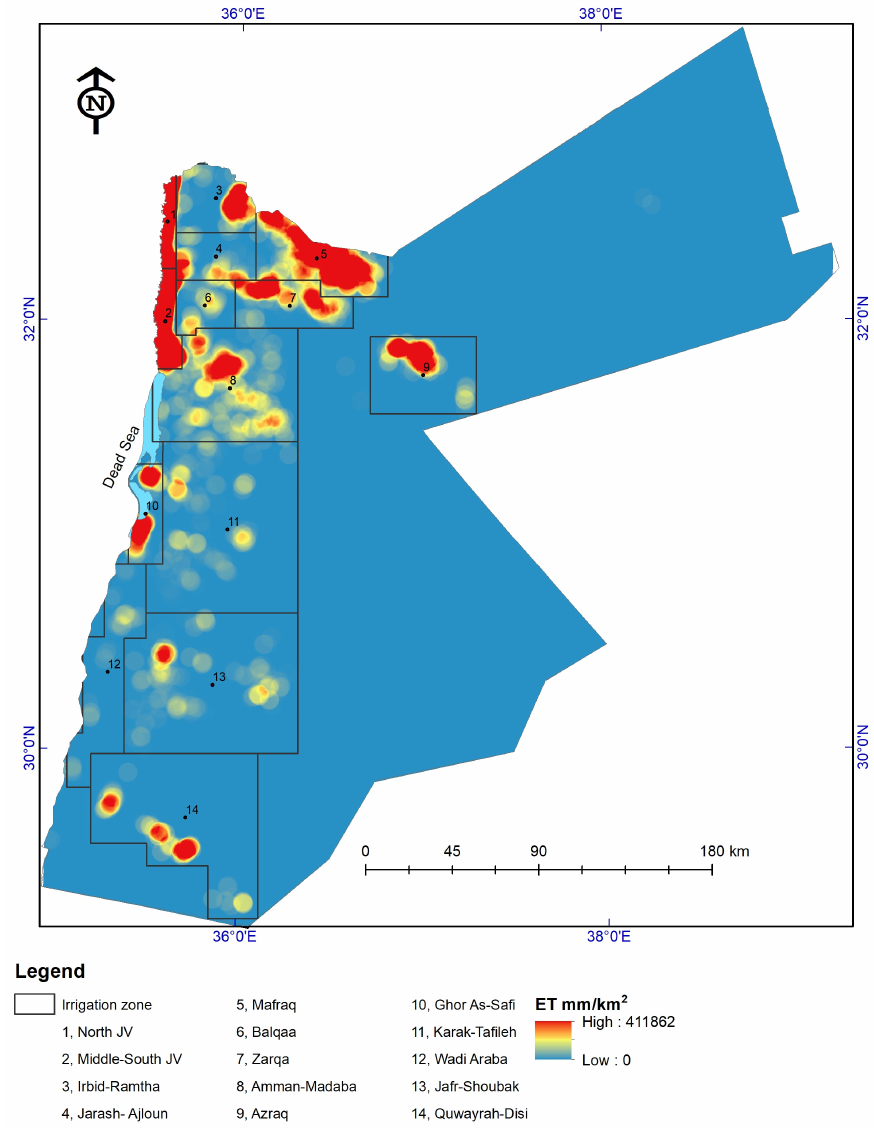
Figure 10. Map of ET density (mm/km 2 ) for irrigated areas in 2017 and irrigation zones in Jordan. In terms of NDVI-Kc correlations, the study showed significant ( p < 0.05) linear rela- tionships between NDVI and Kc for the different irrigated crops in Jordan (Table 3). An